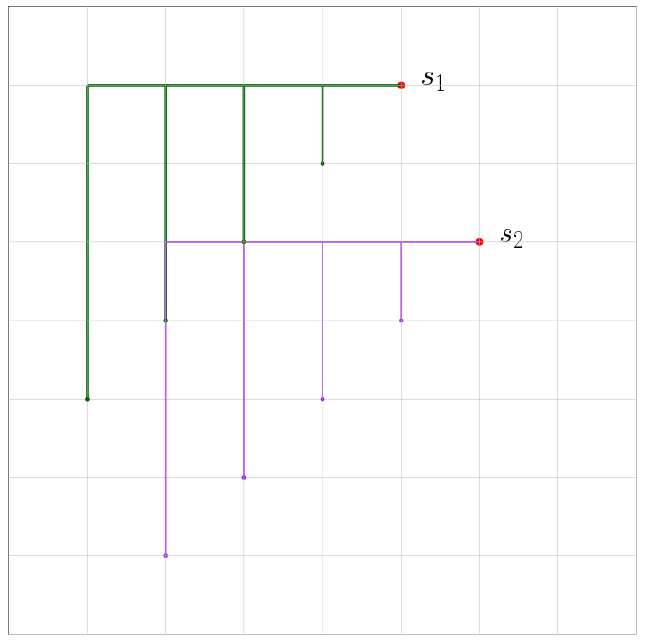
Figure 5. Relevant lower left parts of shortest path trees rooted in top right quarter.